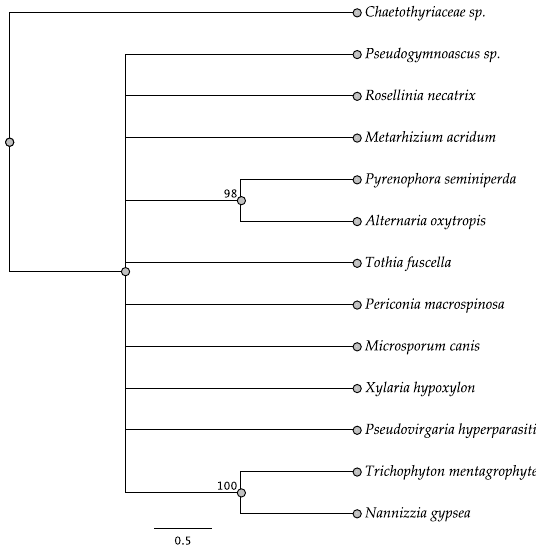
Figure 10. Maximum parsimony DNA tree resulting from the analysis of the swnH2–swnK intergenic region sequence data. Bootstrap confidence values from 1000 bootstrap replicates are presented at each corresponding node. Fungal orders are indicated next to each organism/clade.